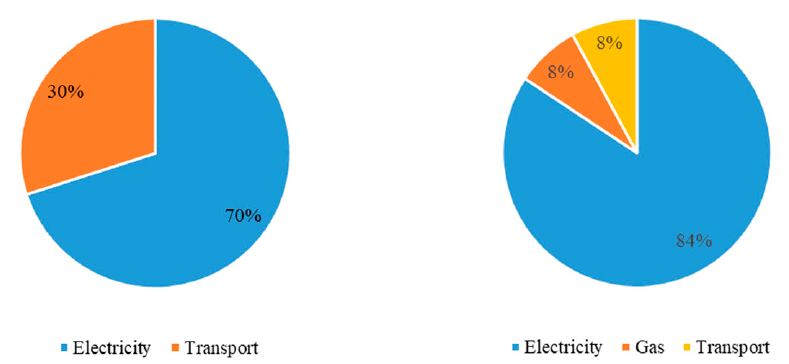
Figure 7. Hotspots GWP mechanical recycling ( left ) and pyrolysis ( right ). resulting grind sizes. We assume identical crushing steps to the ones for CRC (Figure 3). However, the results differ from those of the CRC due to a higher amount of concrete in SRC. The concrete demolition for the reinforced concrete is at a GWP of 6.9 kg CO 2 e with a particle size of 8/22 mm (Scenario A). The treatment by a conventional stationary plant (scenario B1) leads to 9.5 kg CO 2 e. The innovative stationary plant produced the finest grains (Scenario B2), which can be used directly in fresh concrete. Consequently, the largest amount of energy is required for crushing, which is also reflected in a GWP of 14 kg CO 2 e, the highest GWP for concrete crushing scenarios. Table 2. LCA CRC-EoL CML2001.